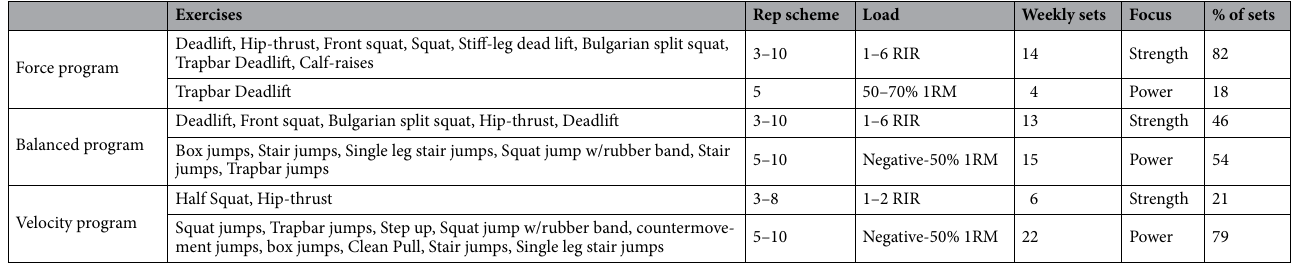
Table 1. Training content for the 3 different training programs. RIR reps in reserve, 1RM one repetition maximum, reps repetitions, Set training